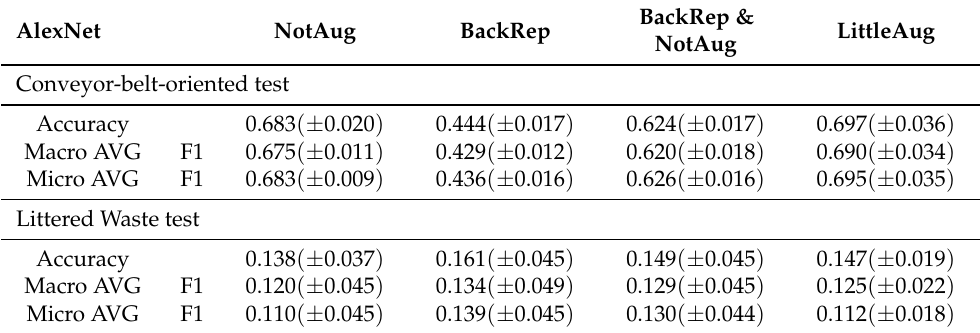
Table 4. Accuracy, Macro Average F1 and Micro Average F1 of AlexNet with the 4 different configu- rations. AlexNet is trained on the conveyor-belt-oriented training set and tested on the conveyor-belt- oriented and on the Littered waste testing sets. Results report the average and the standard deviation of 5 runs with different seeds. Difference in results is not statistically different using the t -test.